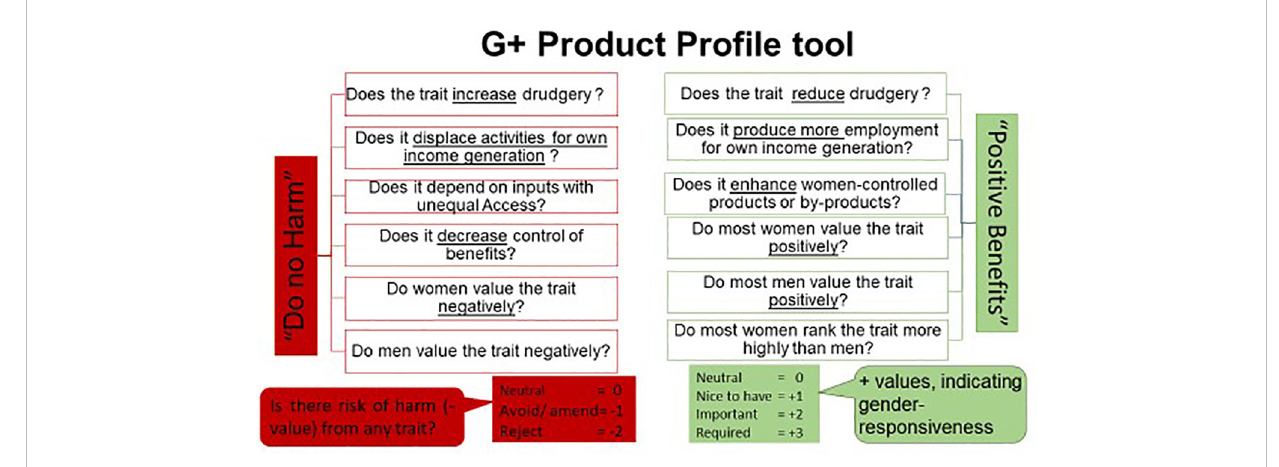
FIGURE 1 The outline of the G+ product pro fi le query for gender impact